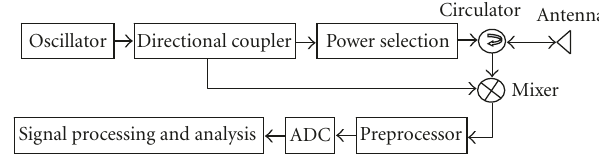
Figure 1: The block scheme of the life-detection